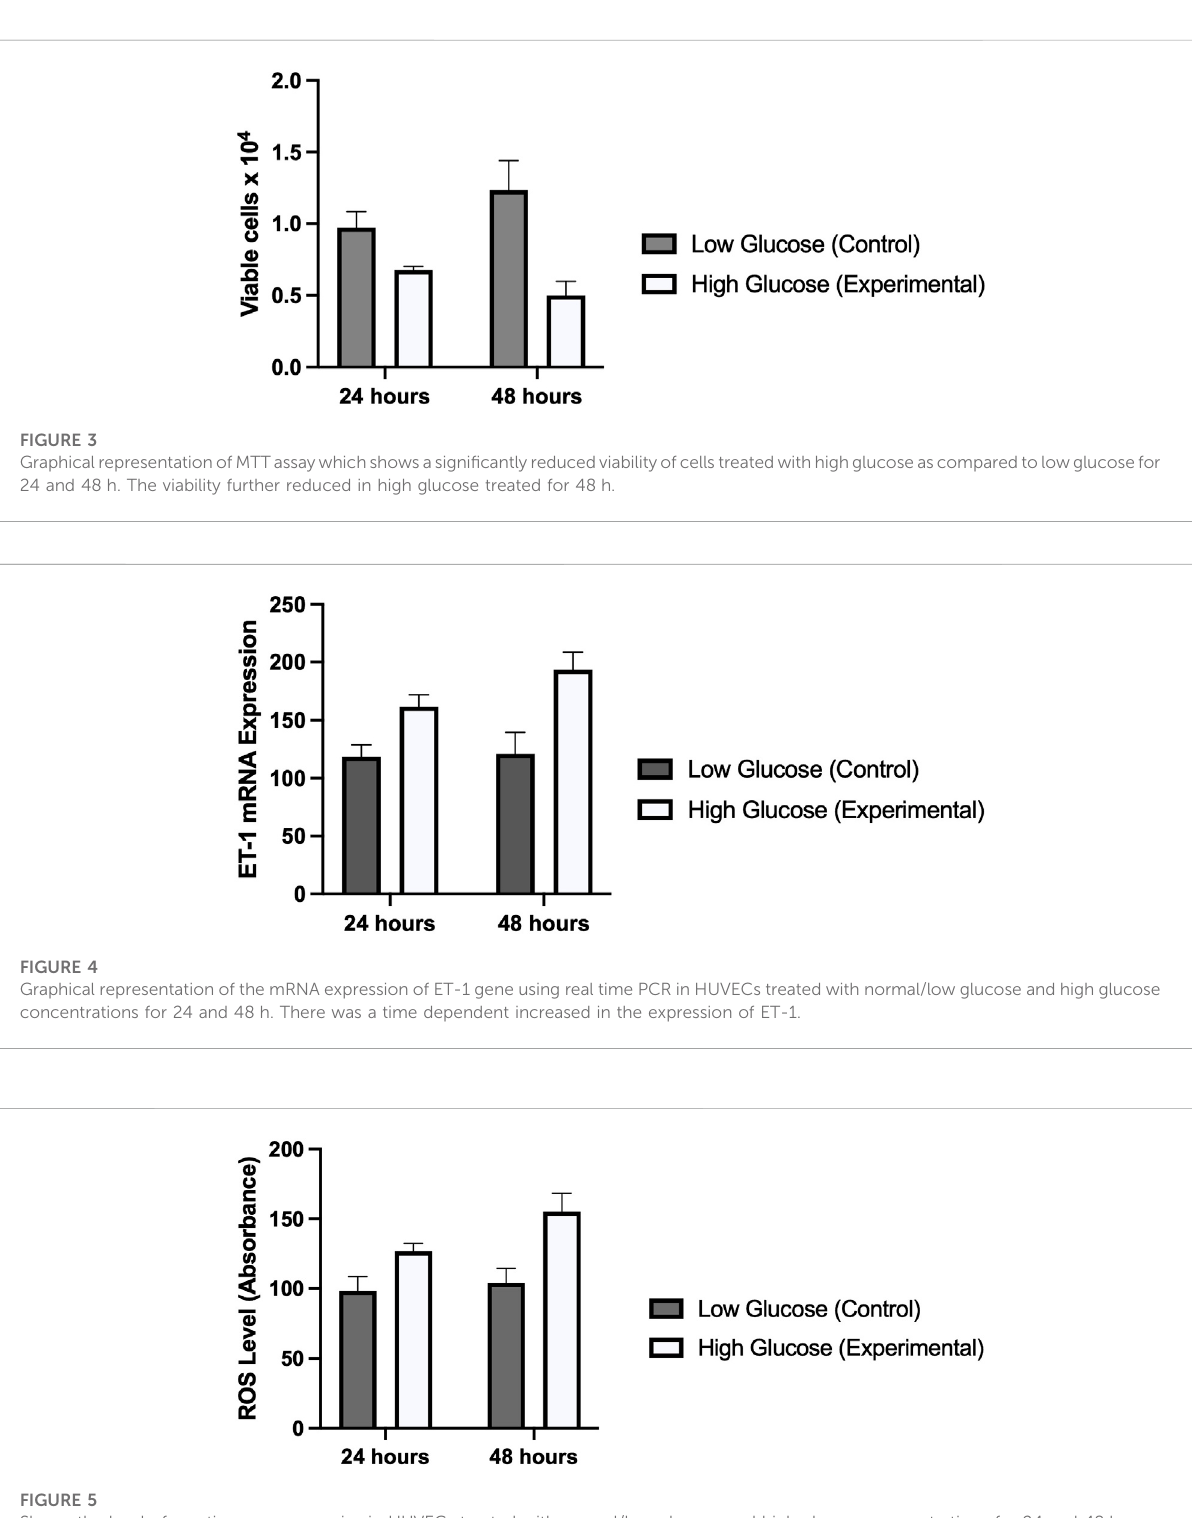
(Thermo Scienti fi c, United States). RevertAid Scienti fi c, United States) was used to synthesize cDNA. ET-1 gene was ampli fi ed by real time PCR using Maxima SYBR Green PCR master mix from Thermo Scienti fi c, United States. Ct and